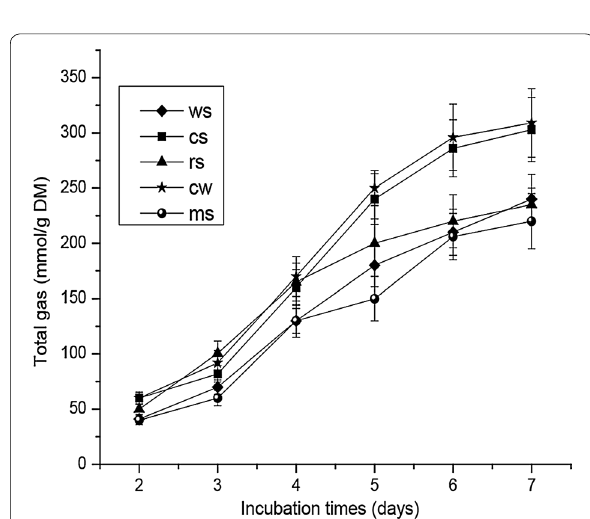
Fig. 4 Cumulative gas production by the ( Piromyces tium ) Yak‑G18 co‑culture grown on chopped wheat straw, corn stalk, rice straw, Chinese wildrye and medicago sativa during the 7 days’ incubation (wheat straw diamond , corn stalk square , rice straw trian- gle , Chinese wildrye star , medicago sativa circle